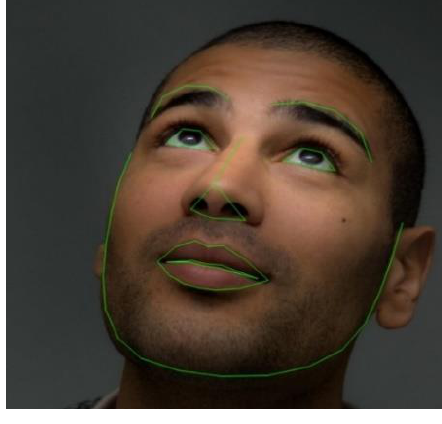
Fig. 4 . Facial landmarks detected